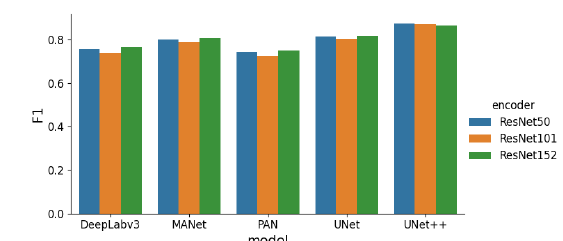
Figure 12 . Reported F1 scores on test data for models trained with ResNet50(blue), ResNet101(orange), and ResNet152(green) for different DL-CNNs.